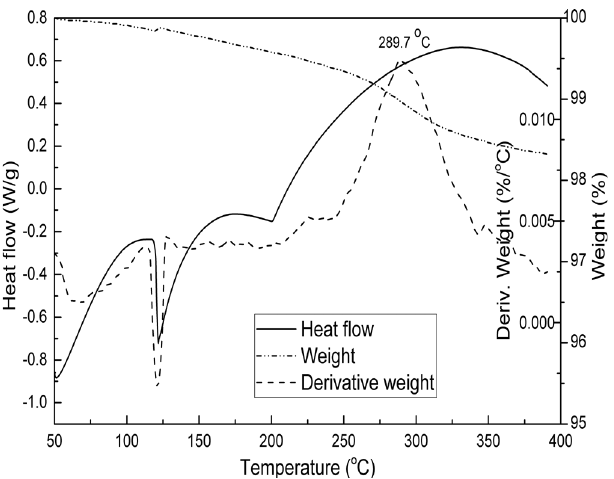
Fig. 2. The DSC/TGA thermogram of In – 48Sn at a heating rate of 10 °